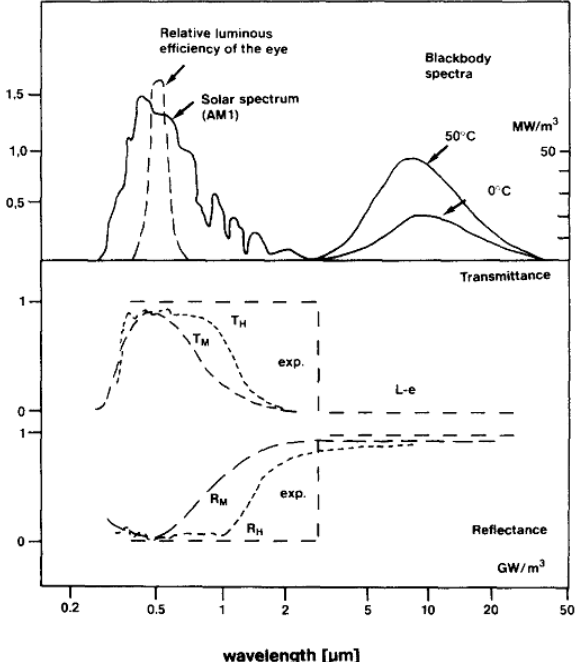
Figure 4. Solar irradiation spectrum, blackbody radiation spectra and characteristics for ideal low ‐ E ( H ) and solar ‐ control glass ( M ) [69] where T and R correspond to Transmission and Reflectance respectively.